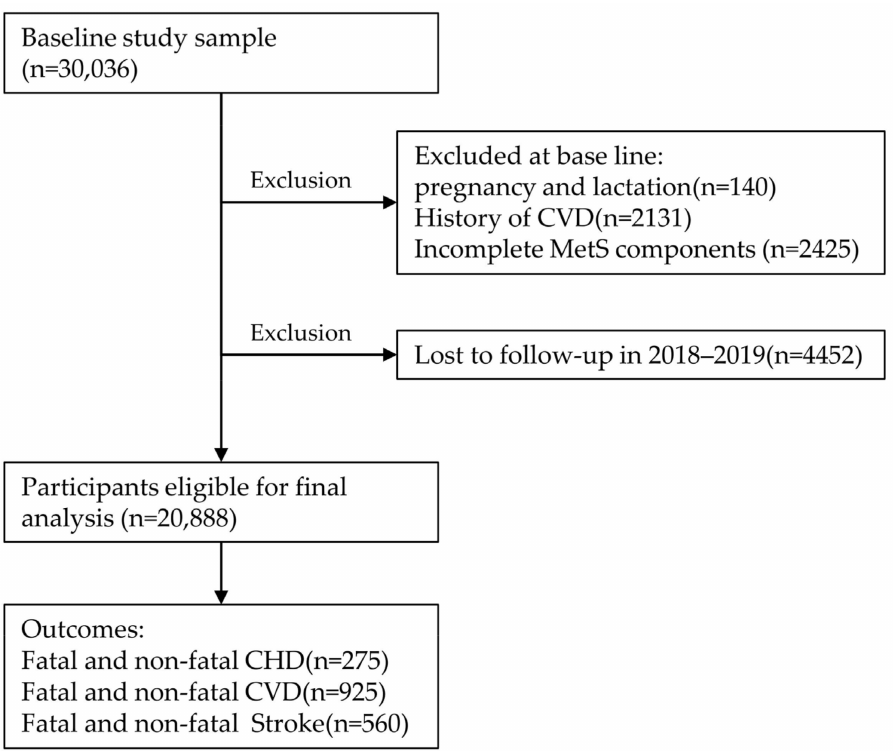
Figure 2. Flowchart of inclusion and exclusion of study participants and cardiovascular outcomes during follow-up. CVD, cardiovascular disease; CHD, coronary heart